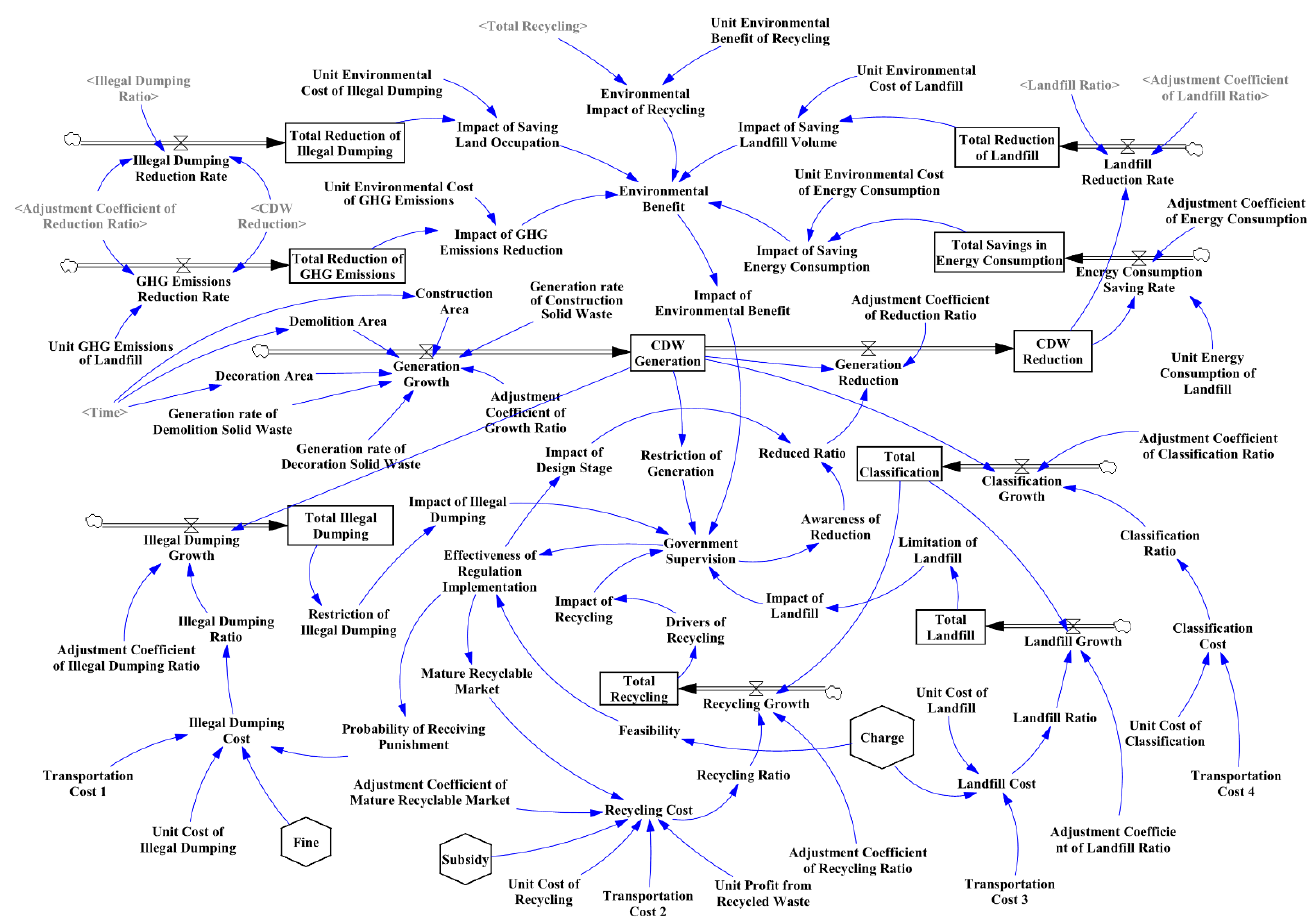
Figure 3. Environmental benefit stock flow chart of CDW resource management. The hexagon indicates the independent variables to be analyzed in this model. The rectangle denotes the stock. The double-linear arrows represent the rate variables. Those with brackets belong to the shadow variables.